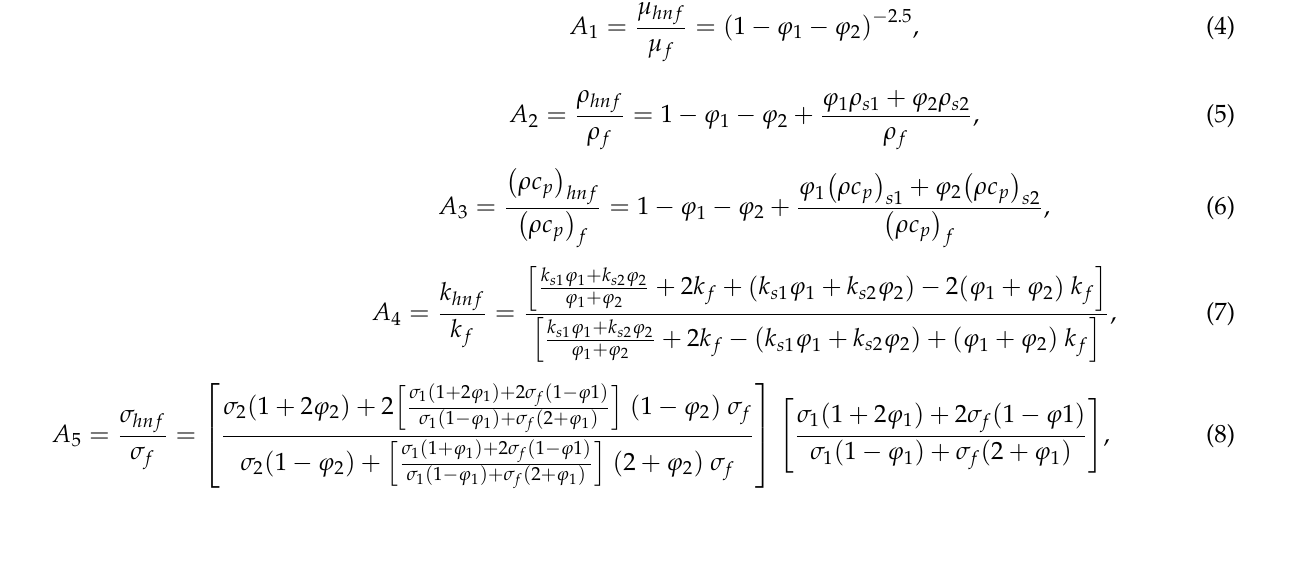
Table 1, ρ hnf , µ hnf , k hnf and